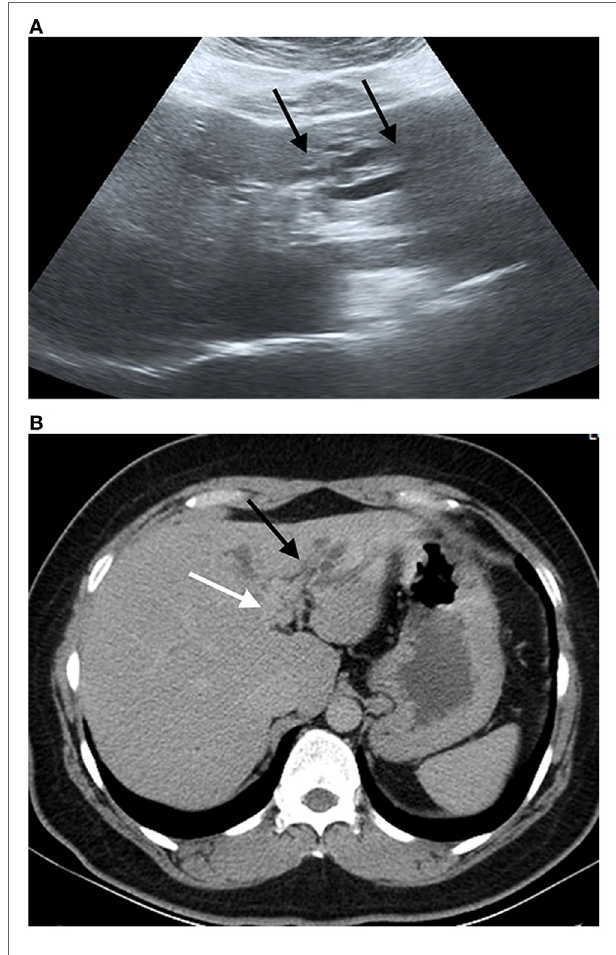
FigURe 3 | Ultrasound image and compute tomography in cholan- giocarcinoma (CCA). (A) Ultrasound image shows a mild degree of dilatation of the intrahepatic bile duct left lobe of the liver (black arrows). (B) Portal phase computed tomography shows infiltrative tumor along left hepatic duct (white arrow) with dilatation of intrahepatic duct in left lobe (black arrow). Final diagnosis is perihilar periductal CCA stage II (AJCC 7th edition).